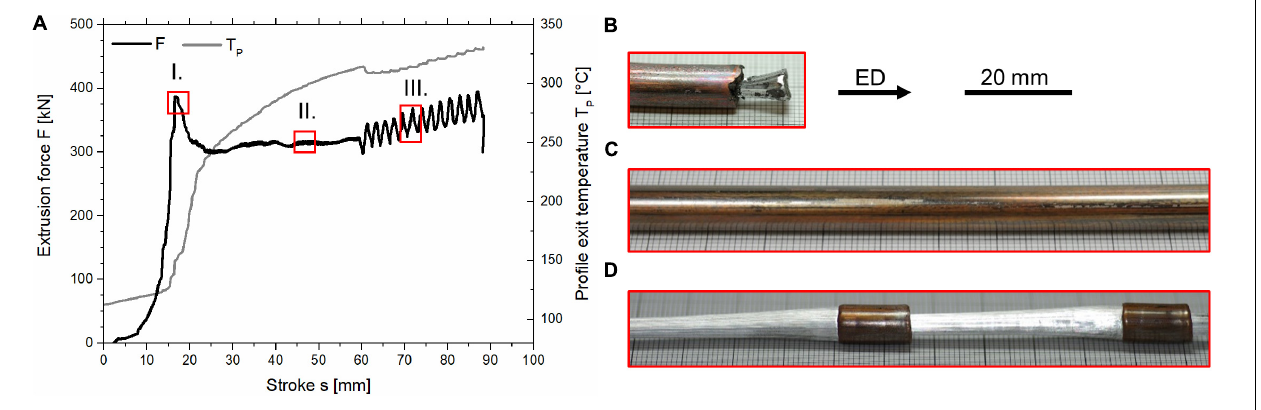
FIGURE 4 | (A) Extrusion diagram and characteristic parts of the extruded composite rod: (B) full aluminum head, (C) sound product, (D) multiple sleeve